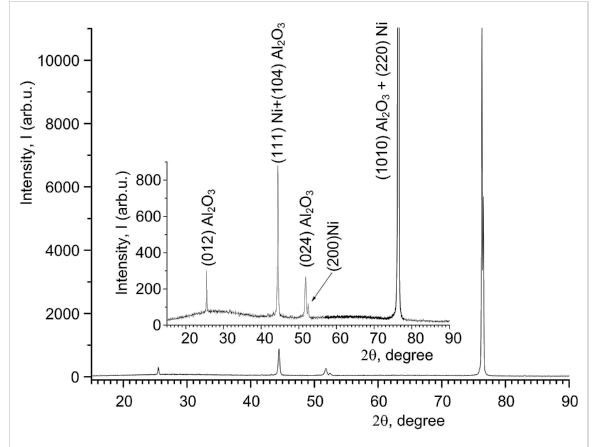
Figure 4: XRD pattern for Ni NWs in alumina template with H PA of 65 μ m and a current density of 3 mA·cm − 2 , deposition duration 120 min.